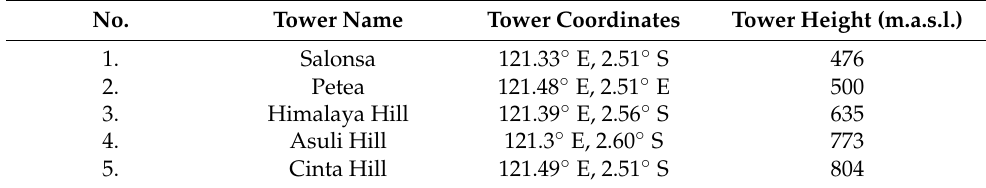
Table 1. All five towers’ names, coordinates, and heights, from the lowest to the highest, in the Larona Basin, Sorowako, Sulawesi.